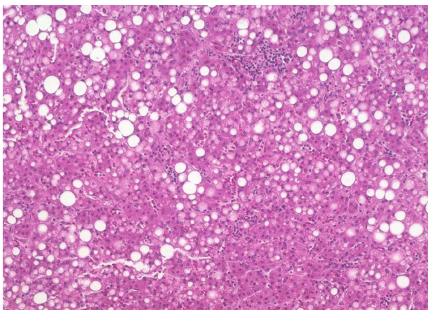
F 5: Original magni�cation 64�. is patient had a typical �brolamellarcarcinoma.Adjacentbutclearlyseparatewasaseparate nodule of well-differentiated hepatocellular neoplasm with fatty change that lacked the features of �brolamellar